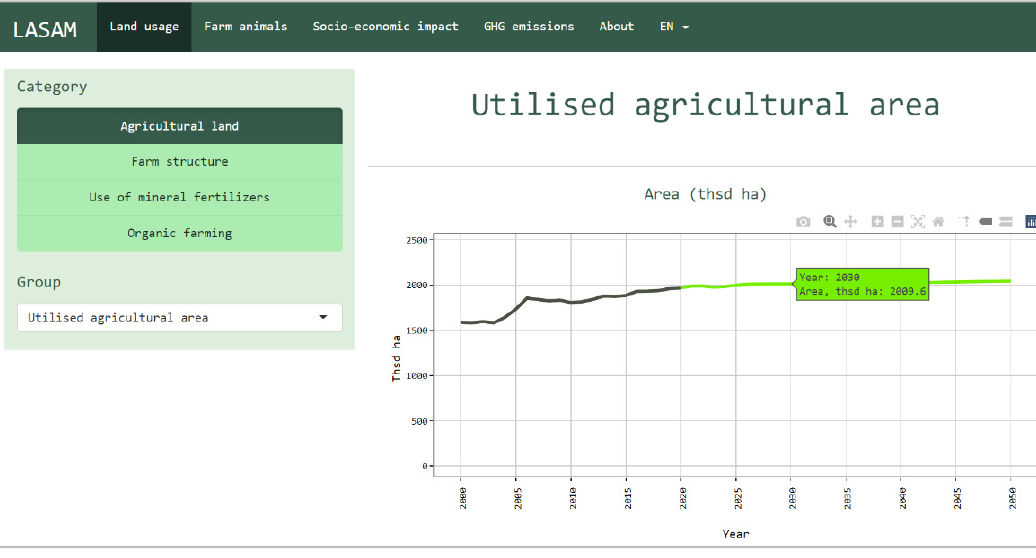
Figure 4. Publicly available LASAM model, in English (example).